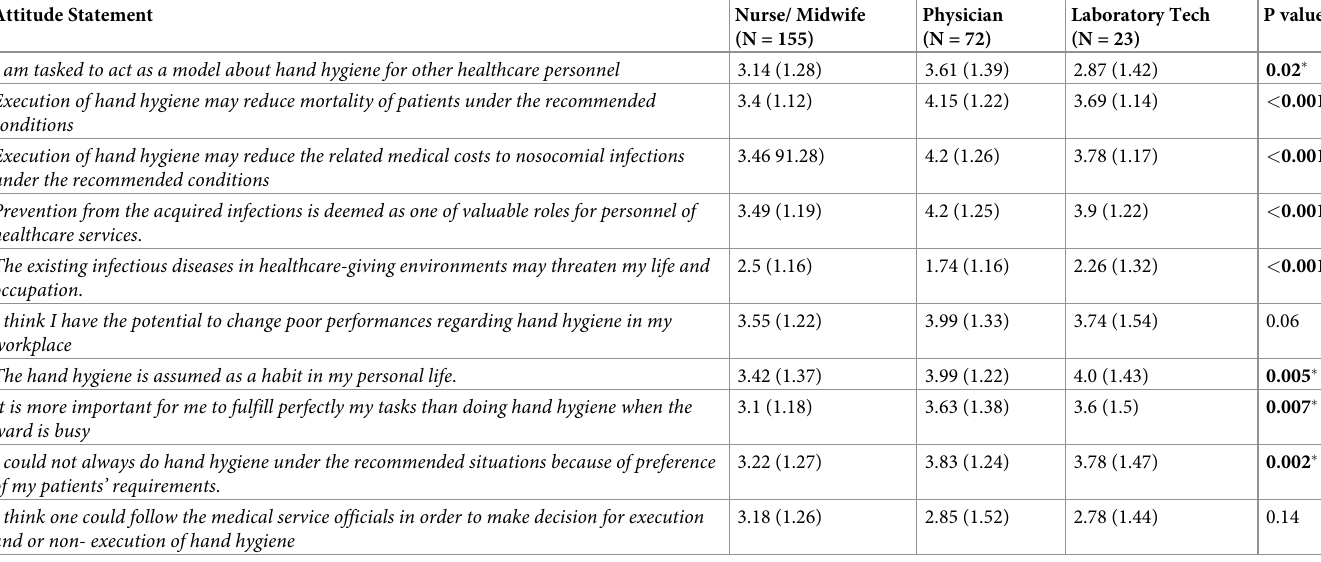
Table 2. Attitude scores by professional category.